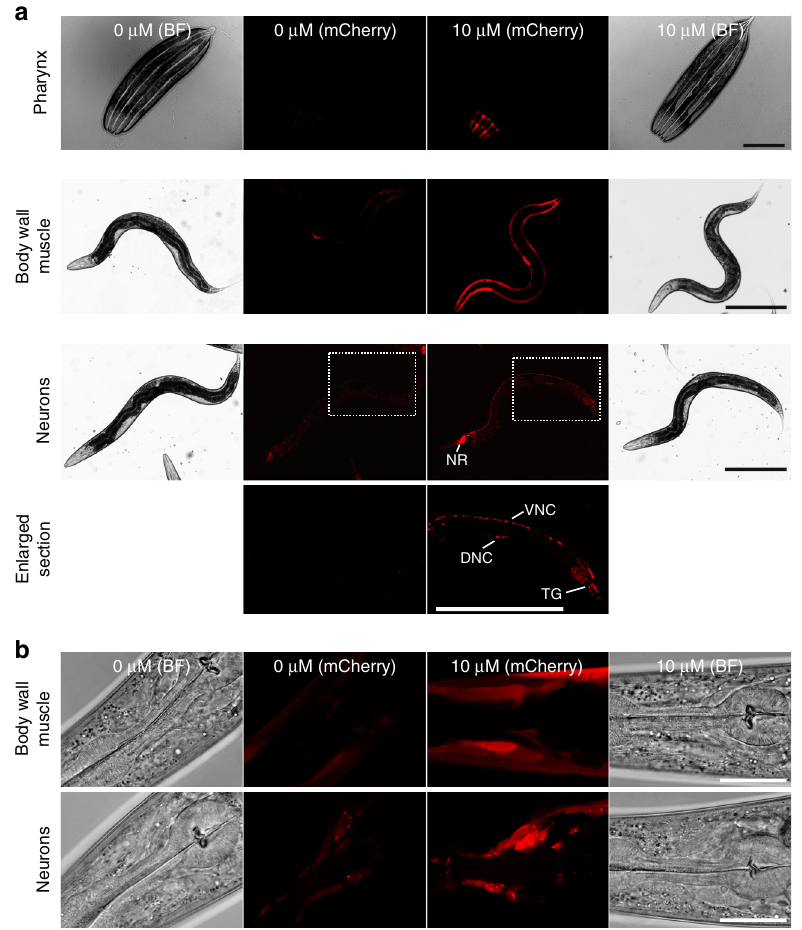
Fig. 3 Aptazymes allow tissue-selective induction of gene expression in C. elegans . a Microscope images of worms carrying 3 ’ -UTR aptazyme-regulated mCherry reporters driven by tissue-speci fi c promoters for the pharynx (myo-2p), body wall muscles (myo-3p) and neurons (rab-3p). Worms were treated with 10 µ M tetracycline from hatch until adulthood (3 days at 20 °C). Boxed sections in images of worms carrying the pan-neuronal reporter are shown enlarged with adjusted contrast to visualize the ventral nerve cord (VNC), dorsal nerve cord (DNC) and tail ganglion (TG). NR nerve ring, BF bright fi eld. Scale bar, 300 µ m. b Confocal microscope images of animals as in a . Images show the head region of worms carrying aptazyme-regulated mCherry reporters expressed in body wall muscles and neurons. BF bright fi eld. Scale bar, 30 µ